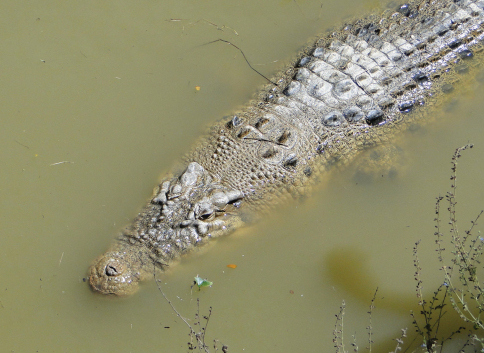
Crocodylus porosus. Captive specimen in an enclosure in Aileu, Aileu District. Photo by Hinrich Kaiser.